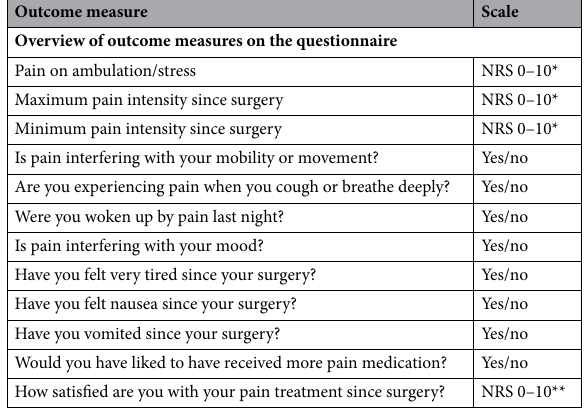
Table 1. Overview of outcome measures on the questionnaire (translated from German). *Numeric Rating Scale (NRS) for pain: 0 = no pain, 10 = most intense pain imaginable. **NRS for satisfaction: 0 = completely unsatisfied, 10 = completely